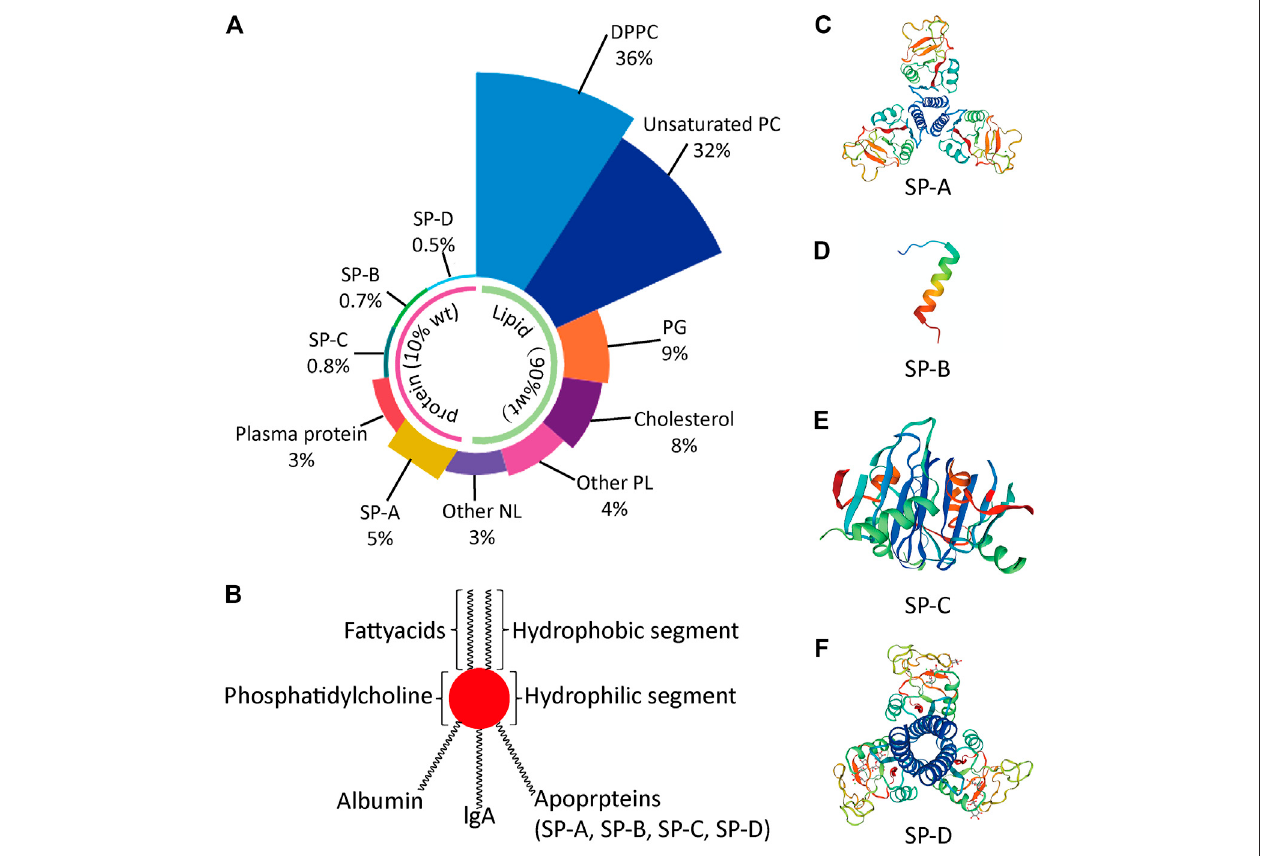
FIGURE 1 | Lung pulmonary surfactant (PS) (A) Relative precent of various components in PS (B) Representative structure of PS (C) Molecular representation of surfactant protein (SP)-A (D) Molecular representation of SP-B (E) Molecular representation of SP-C (F) Molecular representation of SP-D. DPPC, dipalmitoyl phosphatidylcholine; NL, neutral lipid; PC, phosphatidylcholine; PG, phosphatidylglycerol; PL, phospholipid; SP, surfactant protein.